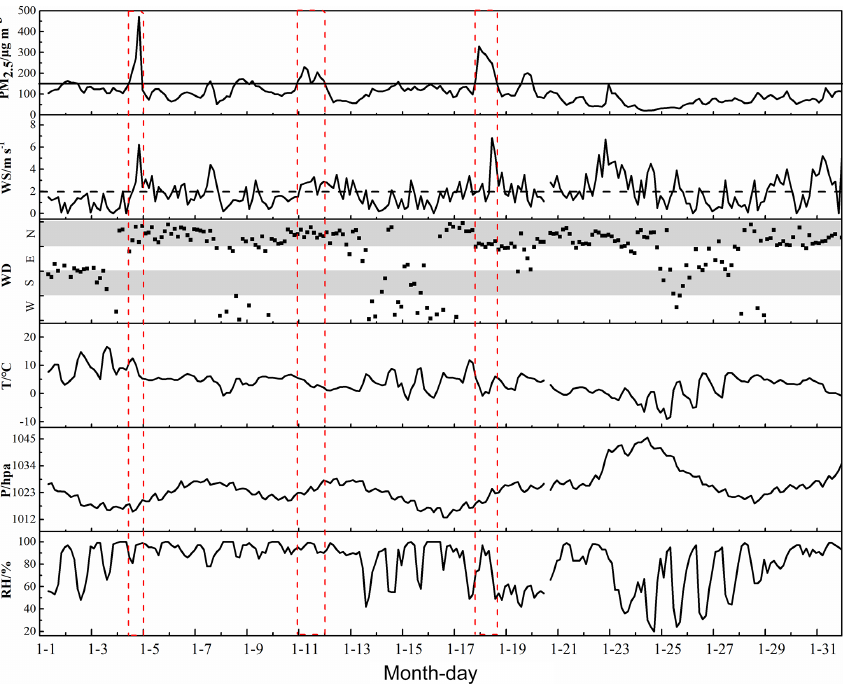
Figure 4. Hourly variations in meteorological elements and PM 2 . 5 concentrations in Wuhan in January 2016. Heavy air pollution periods are marked with columns in red dashed lines and PM 2 . 5 concentrations exceeding 150µgm − 3 (solid line in the upper panel).